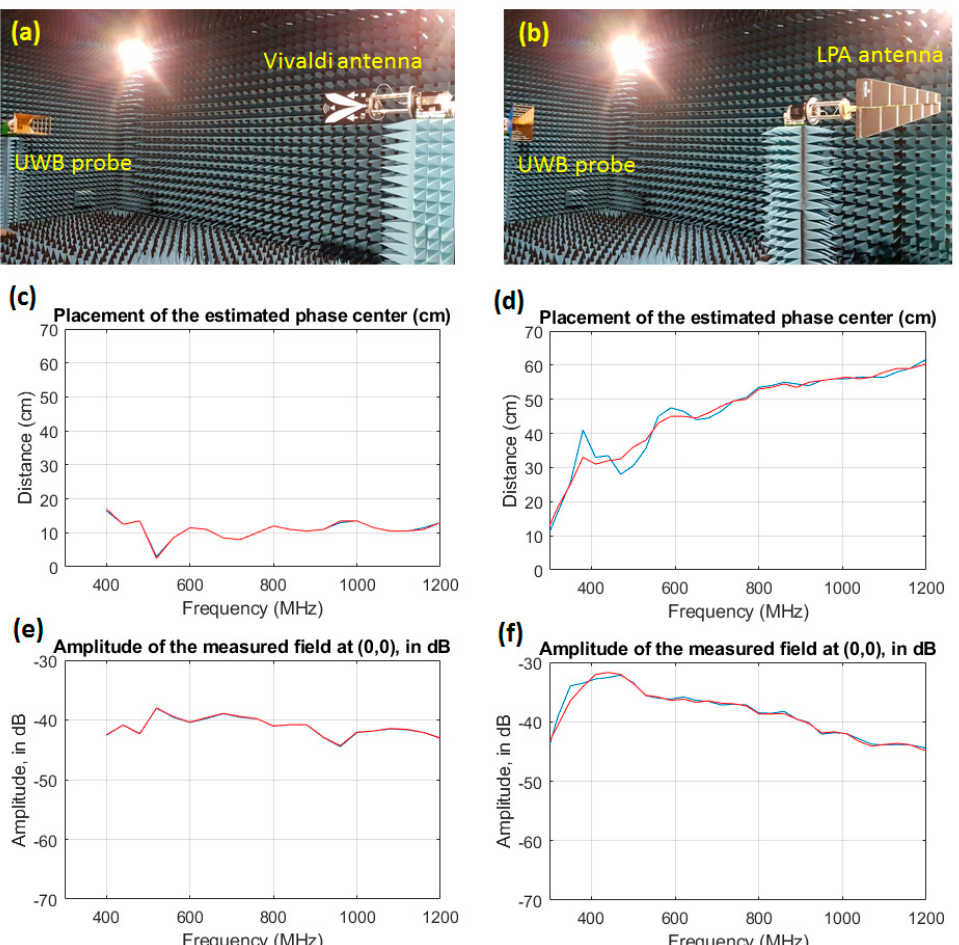
Figure 14. Measurement setup of the Vivaldi antenna ( a ) and the LPA ( b ) at a spherical range in the anechoic chamber using a UWB probe antenna. Position of the phase center for the Vivaldi antenna ( c ) and the LPA ( d ). The amplitude of the measured field for the Vivaldi antenna ( e ) and the LPA ( f ). The blue line corresponds to the E-plane and the red line corresponds to the H-plane.